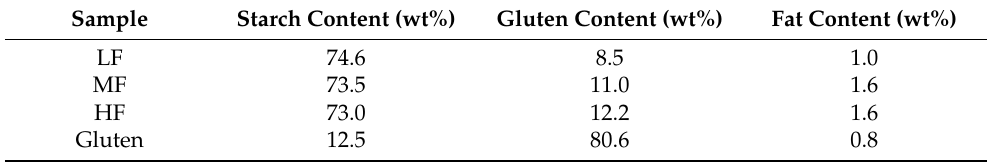
Table 5. Specifications of wheat flours and gluten used in this work (obtained from the manufacturer).